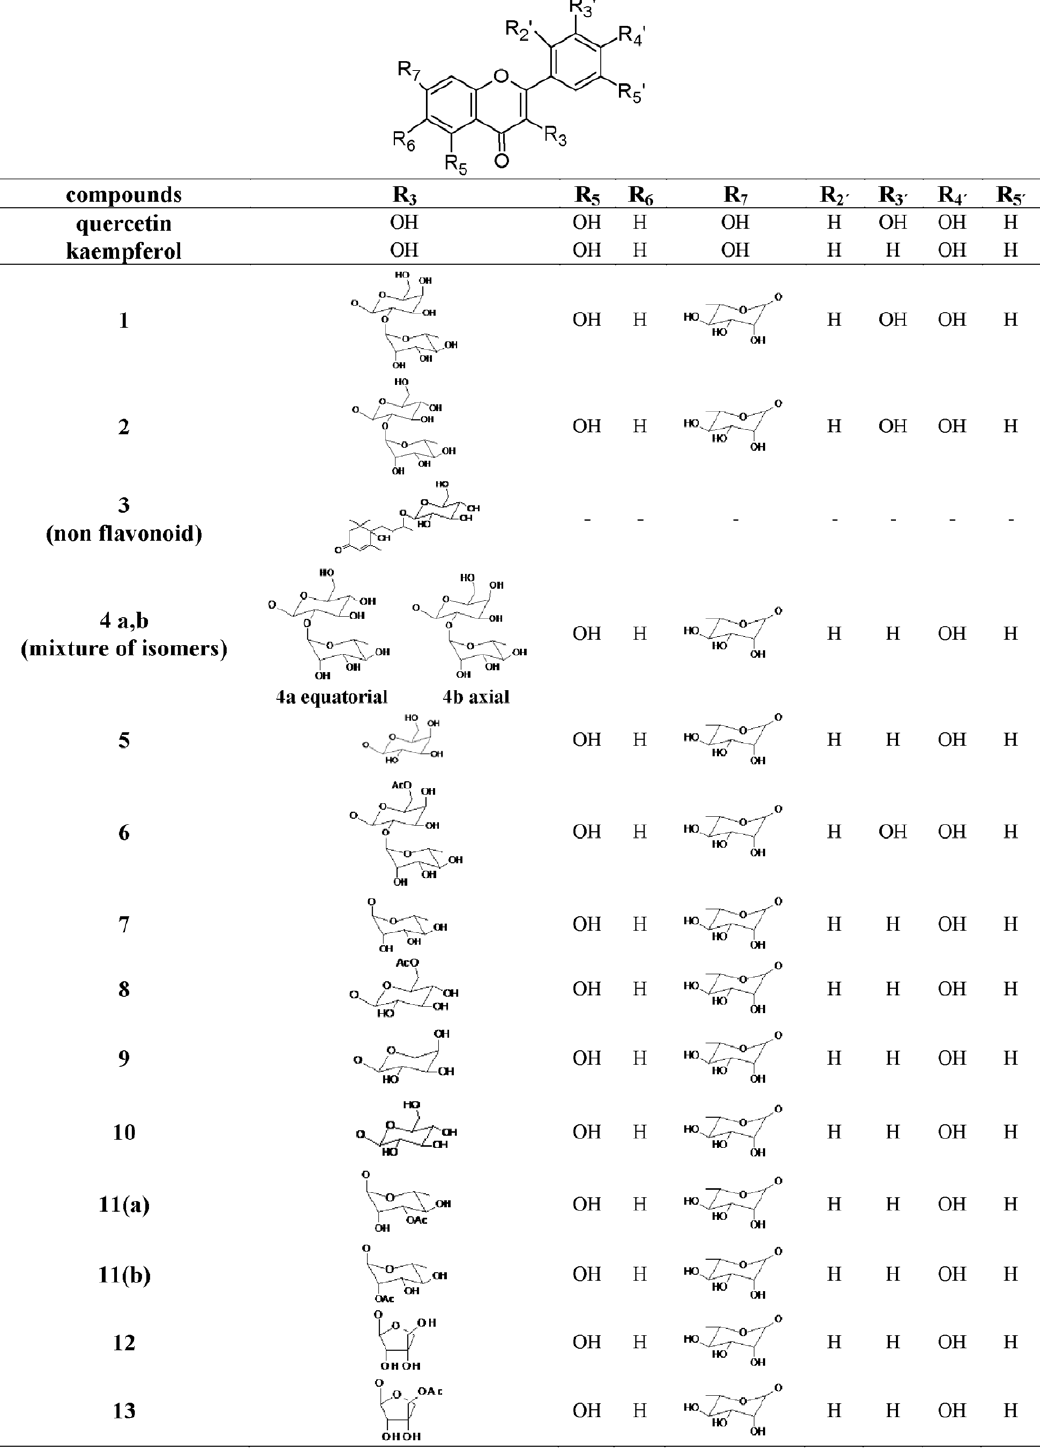
nopyranoside; Compound 9 : Kaempferol 3- O - a -L-arabinopyrano- syl-7- O - a -L-rhamnopyranoside; Compound 10 : Kaempferol 3- O- b - D-glucopyranosyl-7- O- a -L-rhamnopyranoside; Compound 11a : Kaempferol 3- O -(3- O -acetyl- a -L-rhamnopyranosyl)-7- O - a -L-rham-